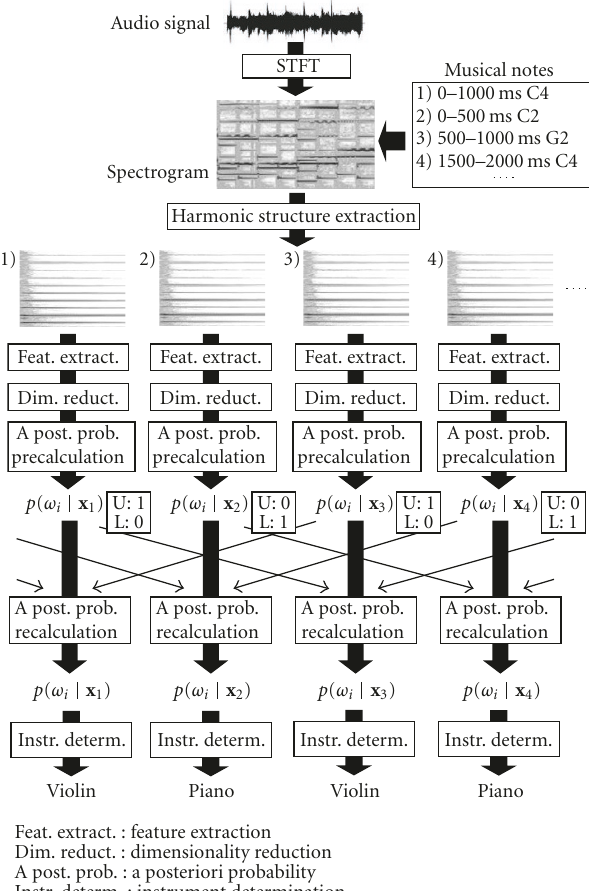
Table 2: Overview of 43 features.